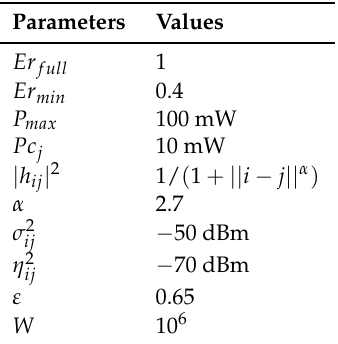
Table 2. Simulation